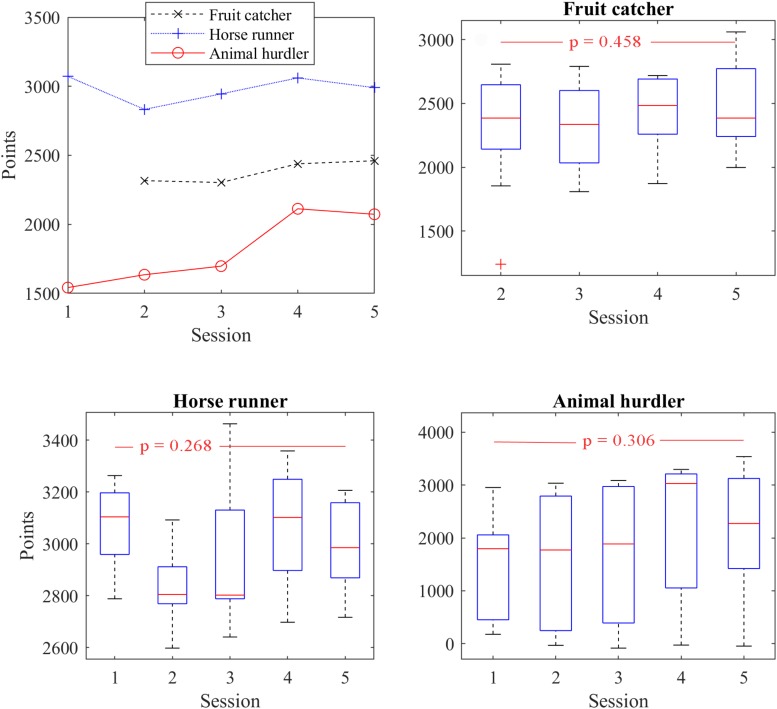
Points achieved in each exergame FruitCatcher (FC), AnimalHurdler (AH), and Horse Runner (HR). Mean values show that participants performed better at the last and pre-last sessions with the FC and AH games. However, the median values and the interquartile ranges revealed that despite of the noticeable progress in AH we had many participants with low score (p > 0.05).